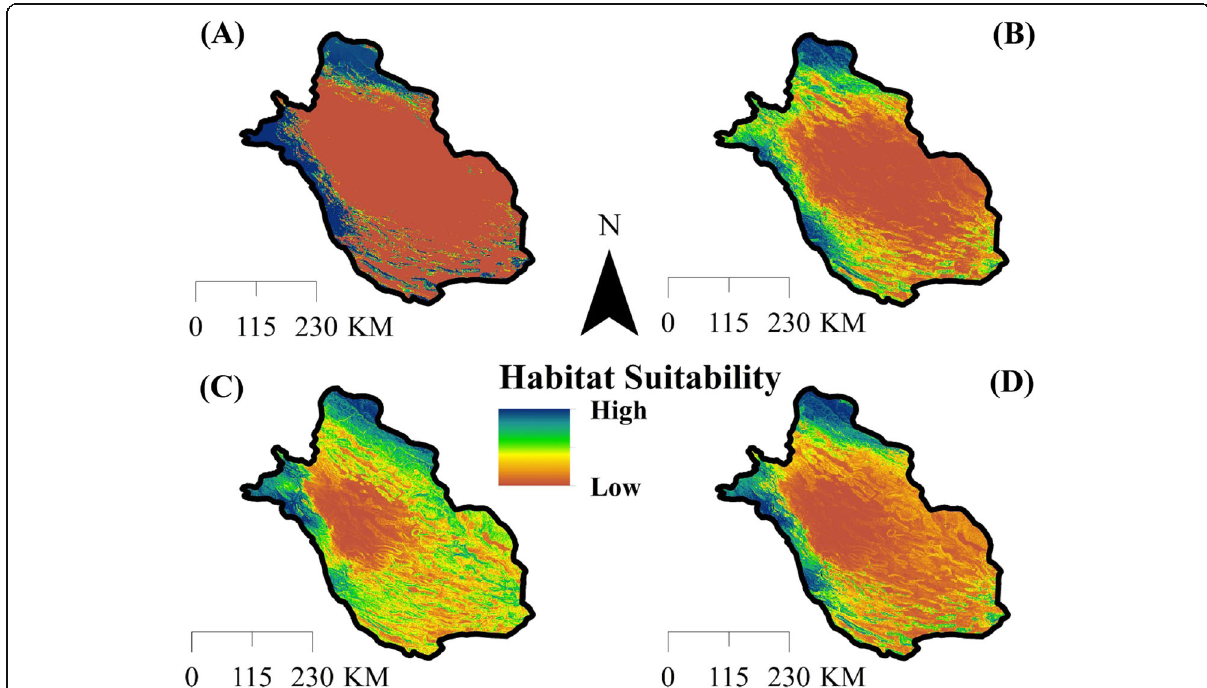
Fig. 3 Continuous map of habitat suitability for Amygdalus scoparia in Fars Province, southern Iran. a BP-ANN model, b GLM model, c MaxEnt model, and d ensemble technique